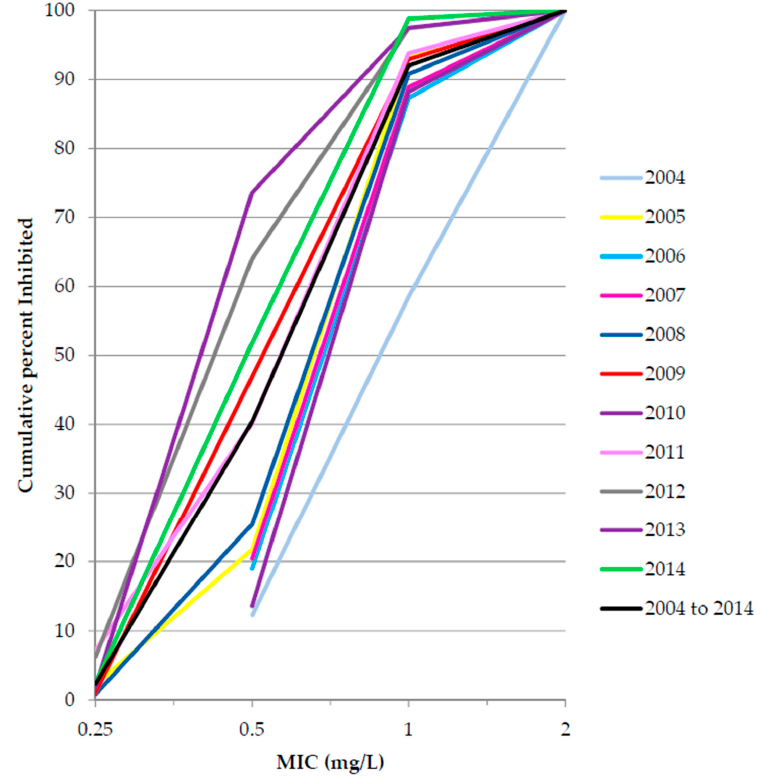
Figure 1. Cumulative minimum inhibitory concentration (MIC) distribution of vancomycin against methicillin-resistant Staphylococcus aureus , Italy 2004 to 2014.